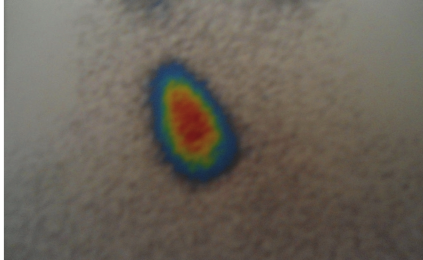
Figure 1: The scintiscanning documented the presence of Graves’ disease within the remaining lobe.